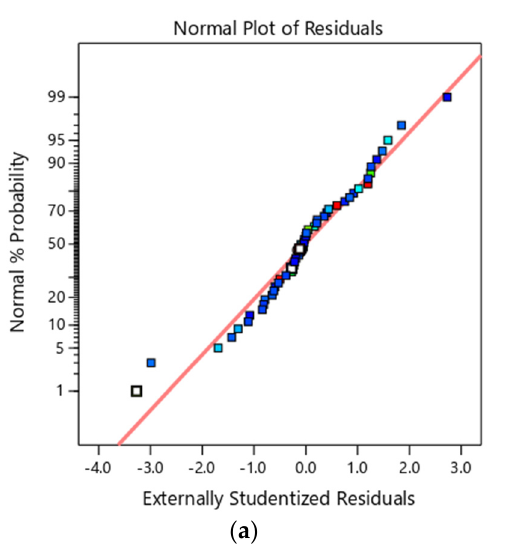
Figure 6. ( a ) Normal probability plot of the externally studentised residuals for the Rc,24 h fitted model, and ( b ) plot of the externally studentised residuals versus Rc,24 h fitted values.